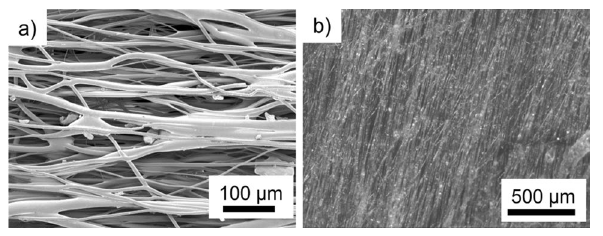
Fig. 3 a SEM image of CN-IF , 200× magnification; b light micro- scope image of CN-IF (polarized light, 2.5× magnification)